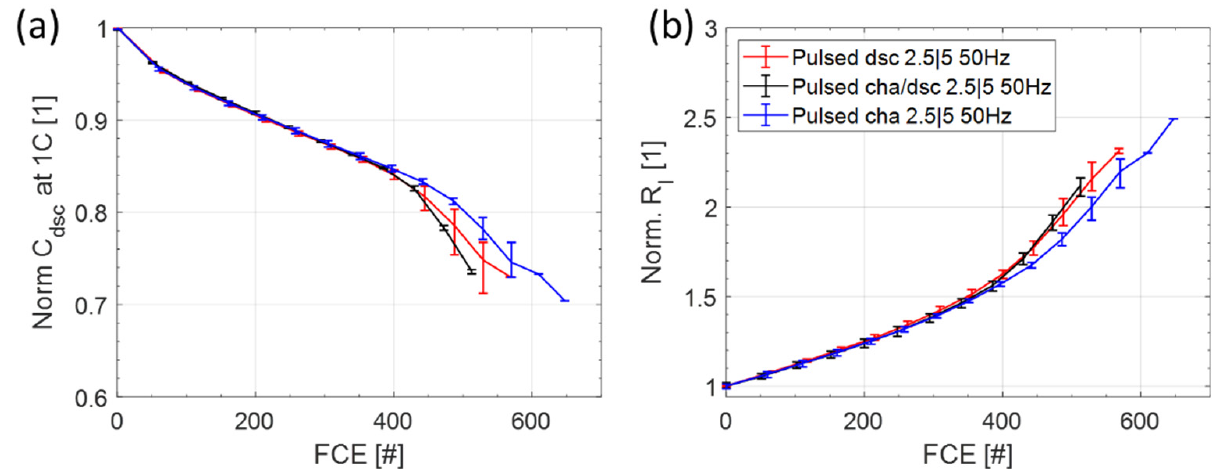
Figure 5. Relative discharge capacity ( a ) and relative internal resistance ( b ) of the switched cells by 50 Hz during discharge (dsc), charge (cha) and charge/discharge (cha/dsc).